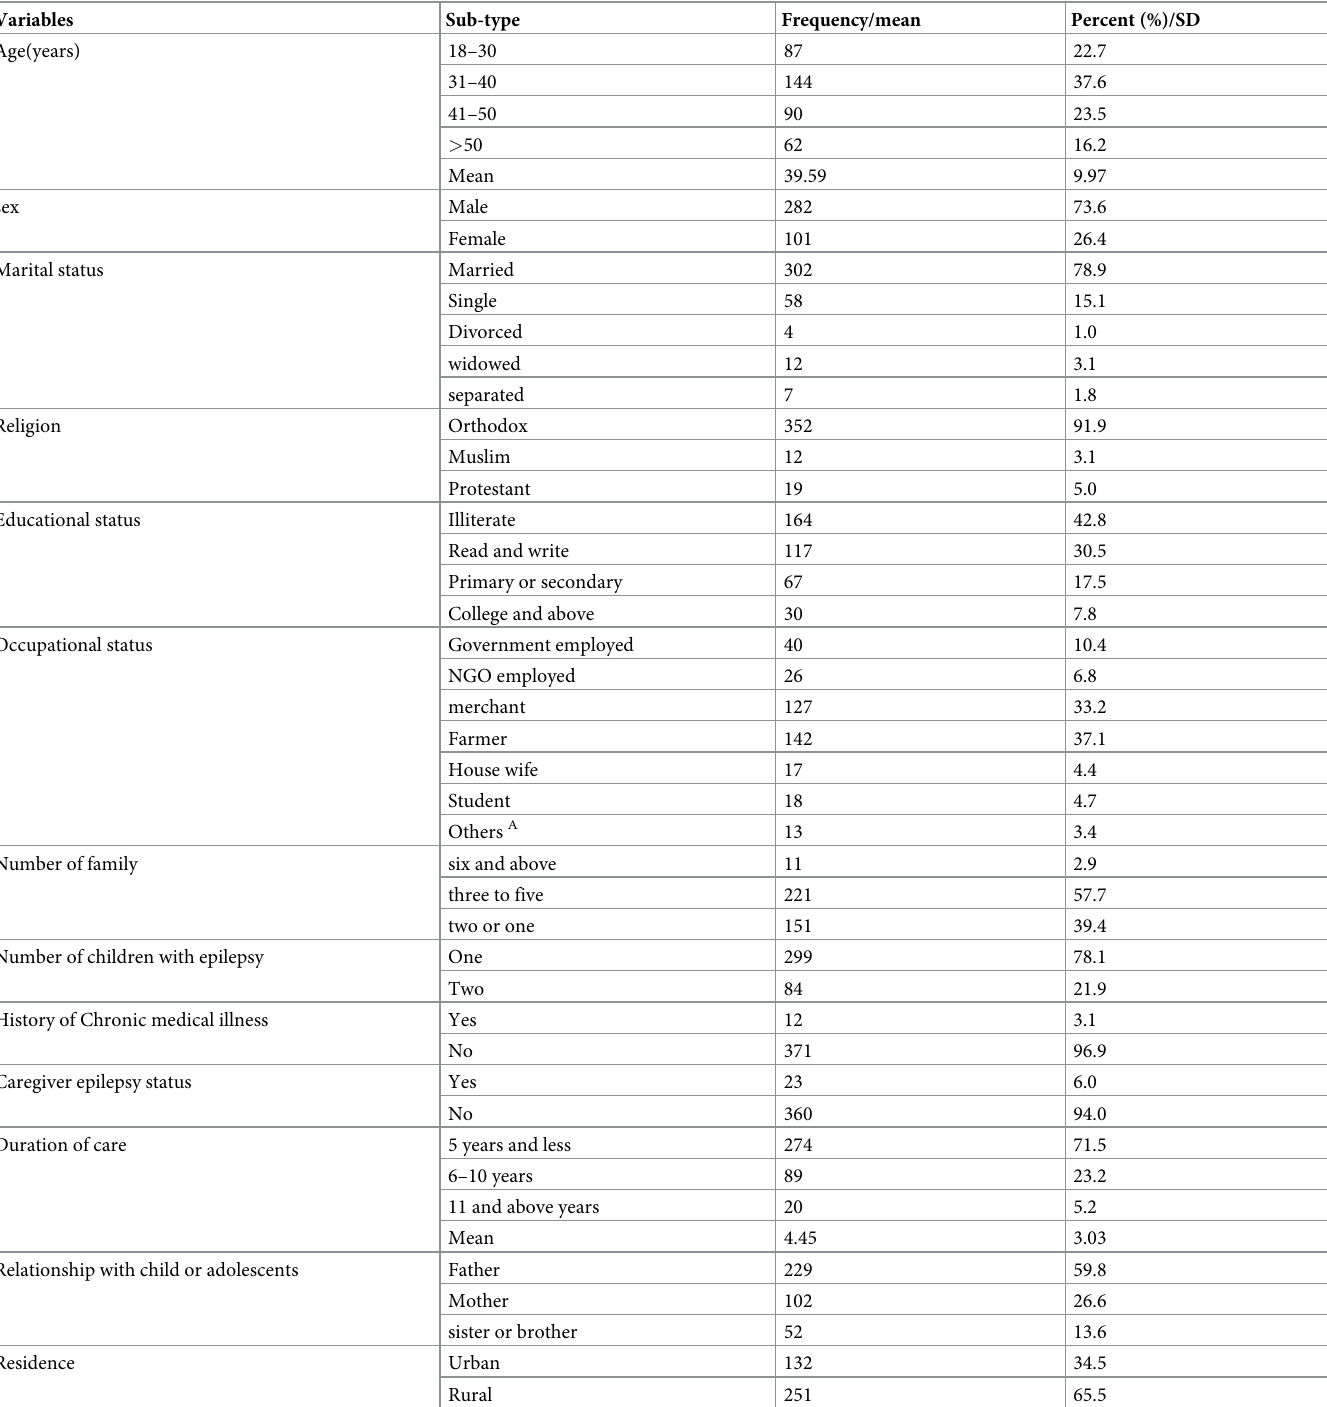
Table 1. Socio-demographic characteristics of caregivers of children and adolescents with epilepsy in selected three hospitals of Amhara region,